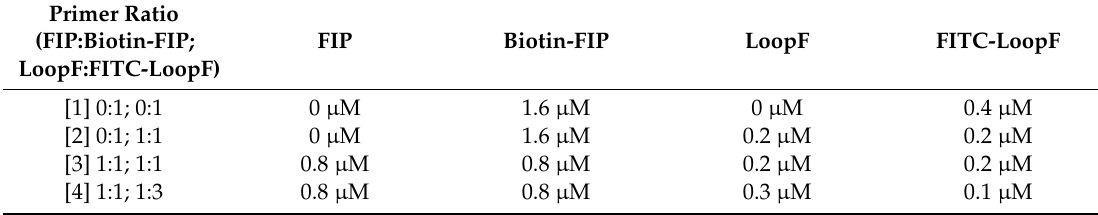
Table 6. Optimization of FIP:biotin-FIP and LoopF:FITC-LoopF primer ratios for fluorescence-based real-time detection of LAMP using SYBR Green